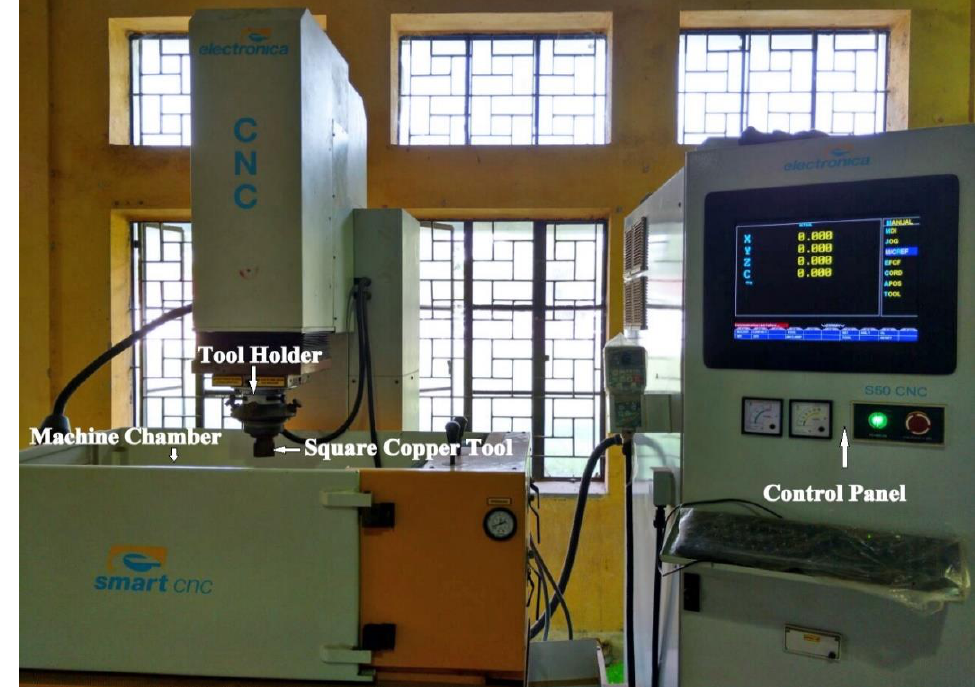
Fig. 1. Illustration of EDM